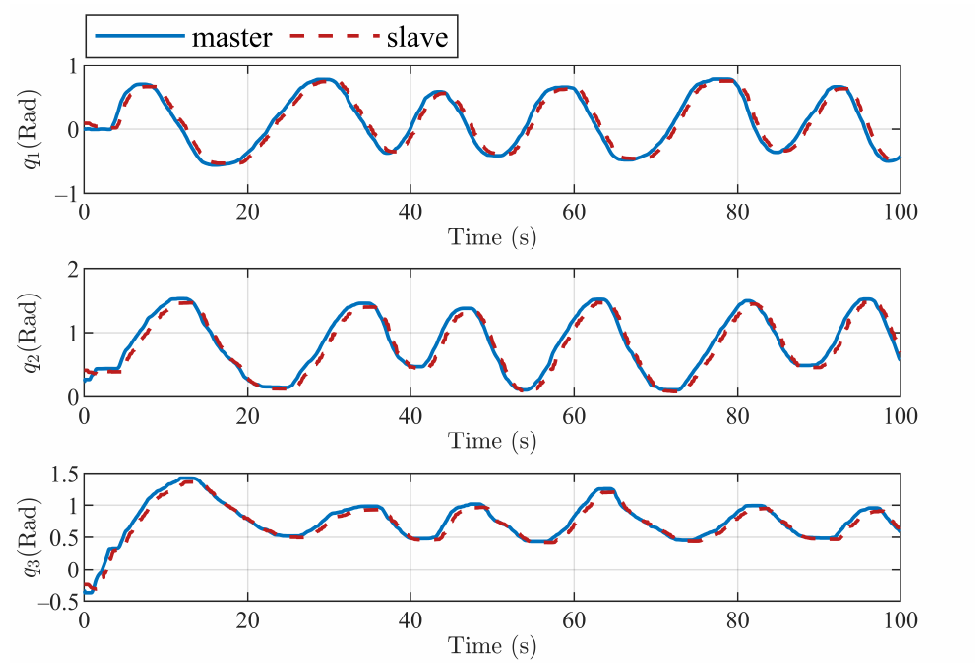
Figure 15. Tracking control performance of three active joints of master and slave robots under experiment case